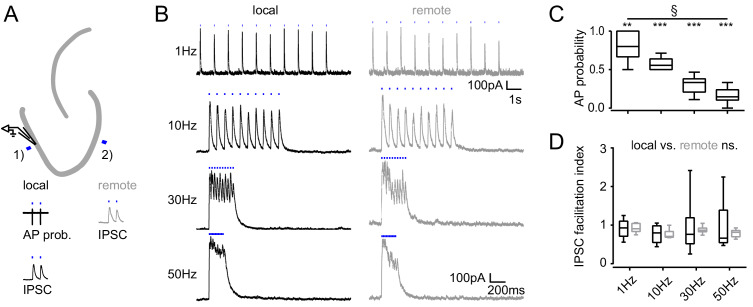
Frequency dependence of feedback inhibition over space.Trains of 10 focal optic stimulations (20 ms duration) were applied either locally (1) or remotely (2) to elicit feedback inhibition. (A) Schematic of the experimental paradigm and example traces of elicited cell attached spikes or IPSCs. (B) Example traces for stimulation at 1, 10, 30 Hz or continuously for 200 ms of a local or remote GC populations (black and grey, respectively). (C) The AP probability index (mean probability during the last three pulses normalized to the first pulse (one-way RM ANOVA, p < 0.001 for frequency, Bonferroni corrected Wilcoxon signed rank test for deviation from 1; p = 0.024, = 0.008, = 0.008 and = 0.008 for 1 Hz, 10 Hz, 30 Hz and continuous stimulation, respectively). (D) Facilitation indices of local (dark grey) and remote (light grey) stimulation (two-way RM ANOVA; p = 0.635, = 0.314 and = 0.687 for location, frequency and interaction, respectively).